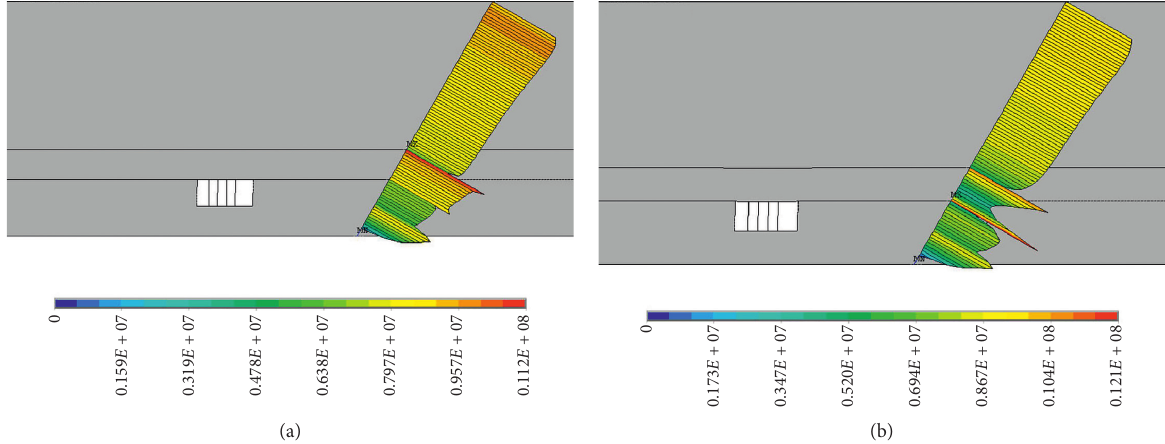
Figure 23: The nephogram of contact pressure when work face is far from the fault (reverse direction fault). (a) Without searching tunnel. (b) With searching tunnel.